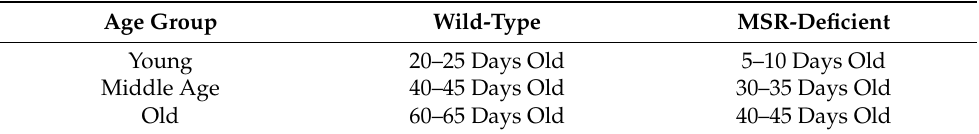
Table 1. Categorization of age groups.